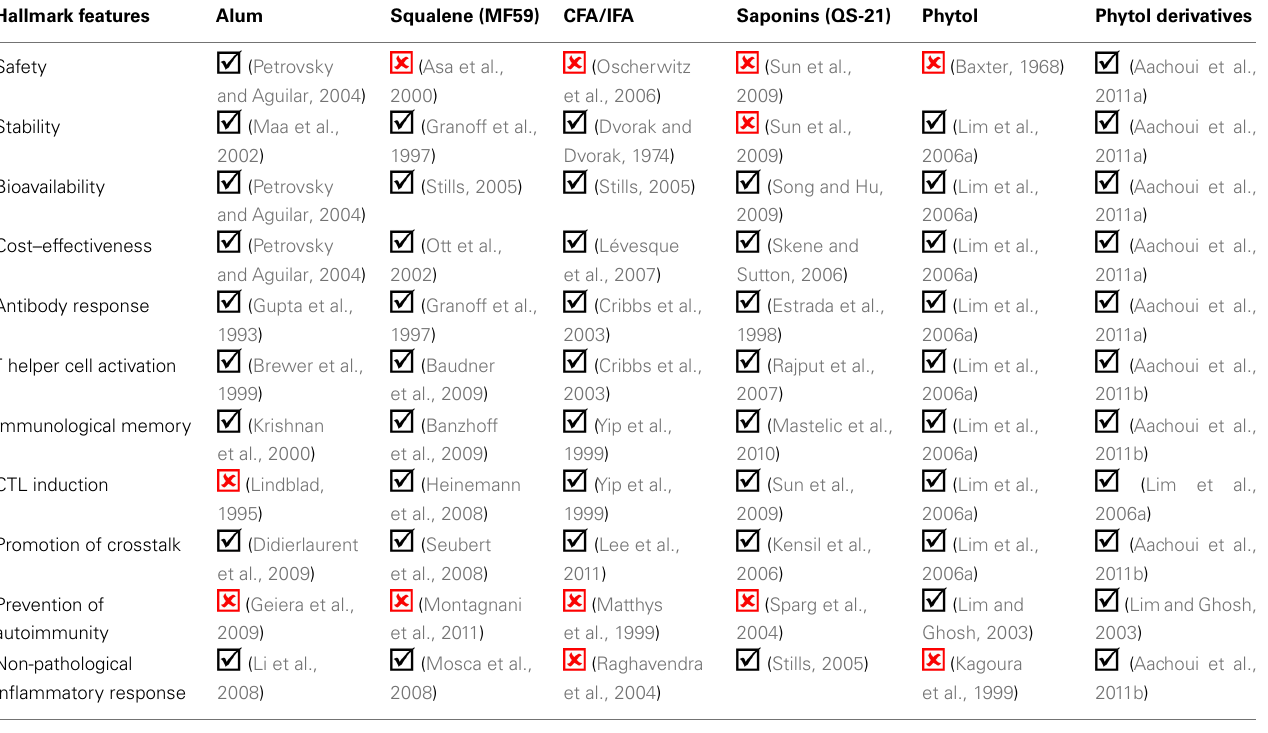
Table 1 |Adjuvanticity of phytol and its derivatives compared to commercially available